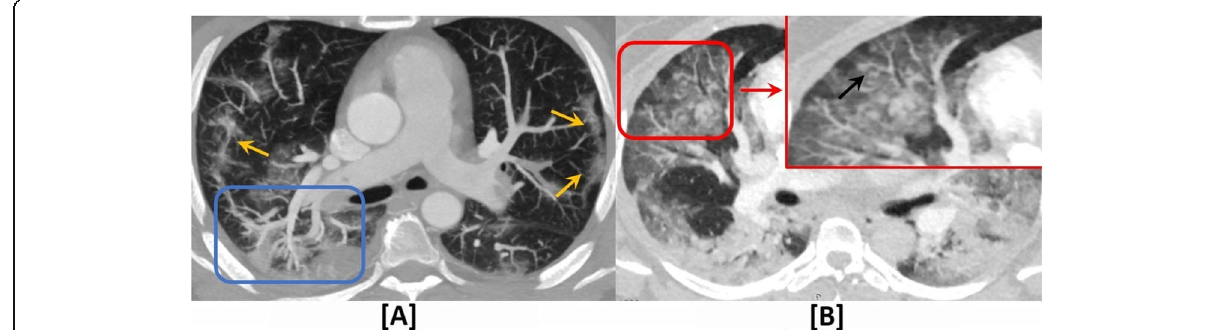
Fig. 3 Indirect CTPA signs of COVID-19-induced pulmonary vascular angiopathy. a A 43-year-old male patient with pulmonary vascular enlargement (PVE) ; axial lung window CTPA showed asymmetrical dilated right lower lobar pulmonary arterial branches (blue square) together with peripheral sub- pleural ground glass patches (orange arrows). b A 37-year-old female patient with vascular tree-in-bud pattern (TIB) ; axial zoomed lung window CTPA showed beaded and branching distal pulmonary